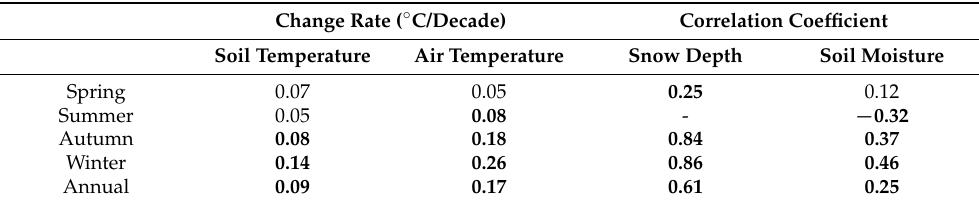
Table 3. Changes in the mean shallow soil temperature and air temperature and correlation between the ∆ T with snow depth and soil moisture across the QTP from 1950 to